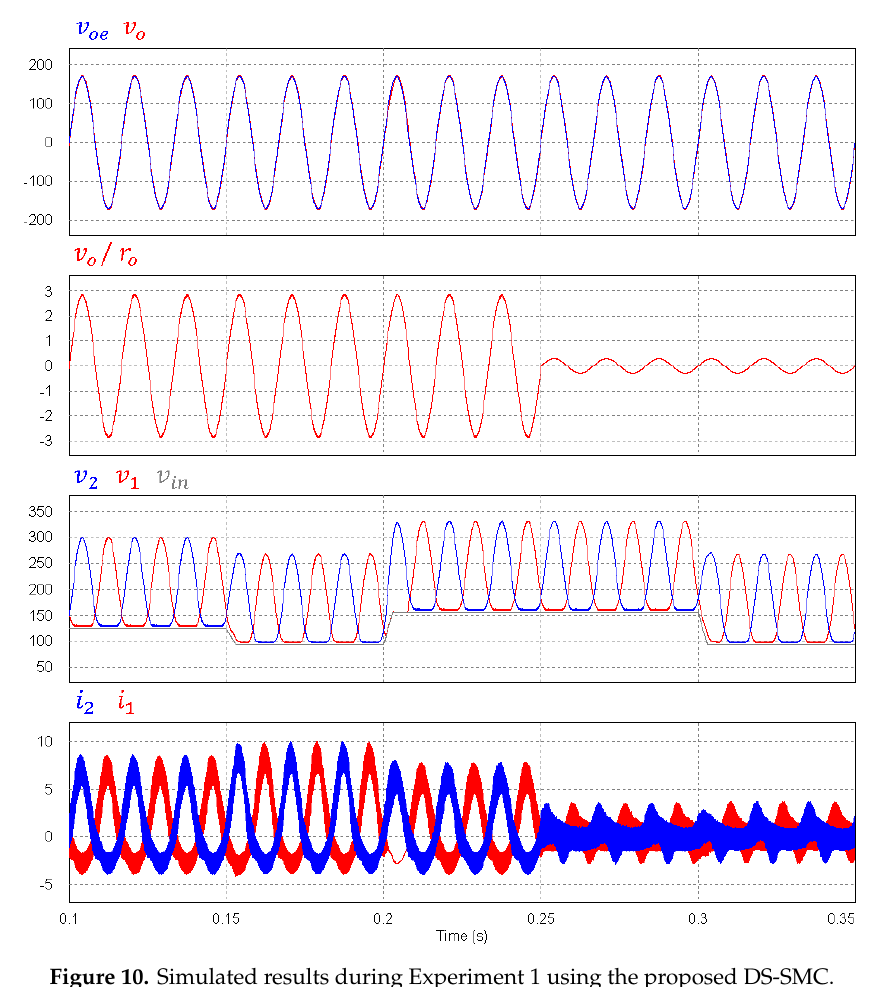
Figure 10. Simulated results during Experiment 1 using the proposed Figure 11. Simulated results during Experiment 1 using the proposed DS-SMC. Table 5. Output voltage quality for simulation test 1 (120 V @ 60 Hz).